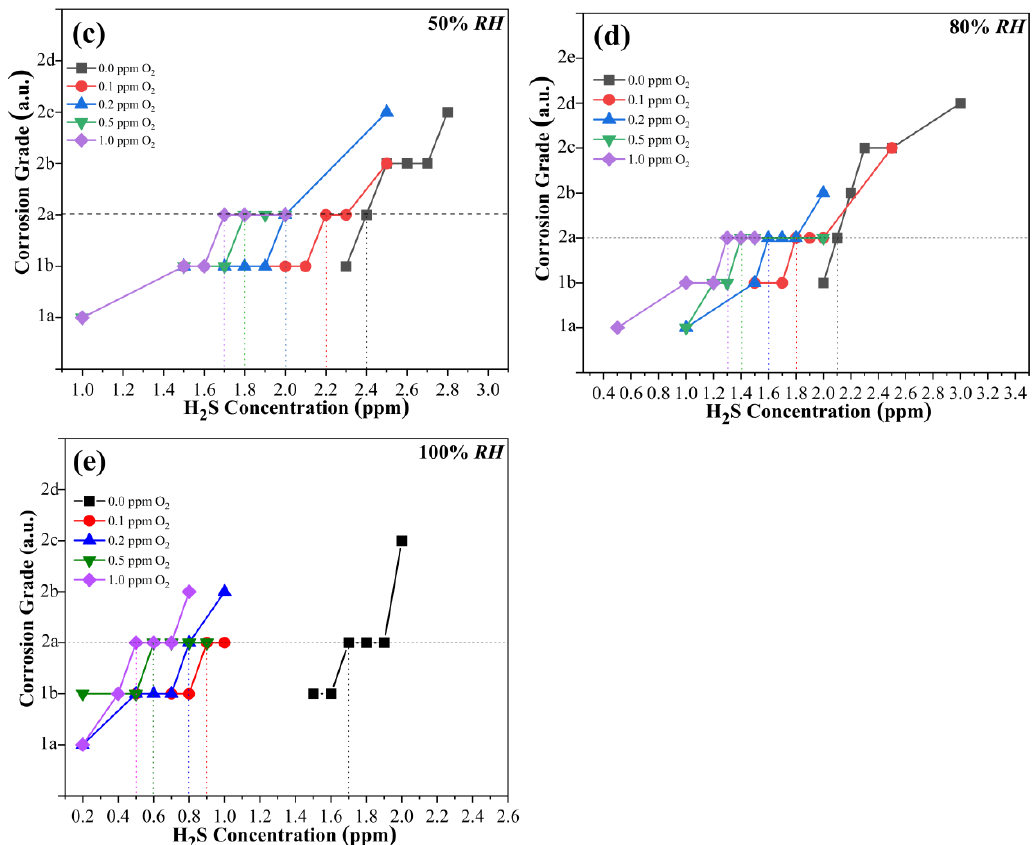
Figure 4. Influence of oxygen content on CP at ( a ) 0% RH , ( b ) 30% RH , ( c ) 50% RH , ( d ) 80% RH , ( e ) 100% RH .